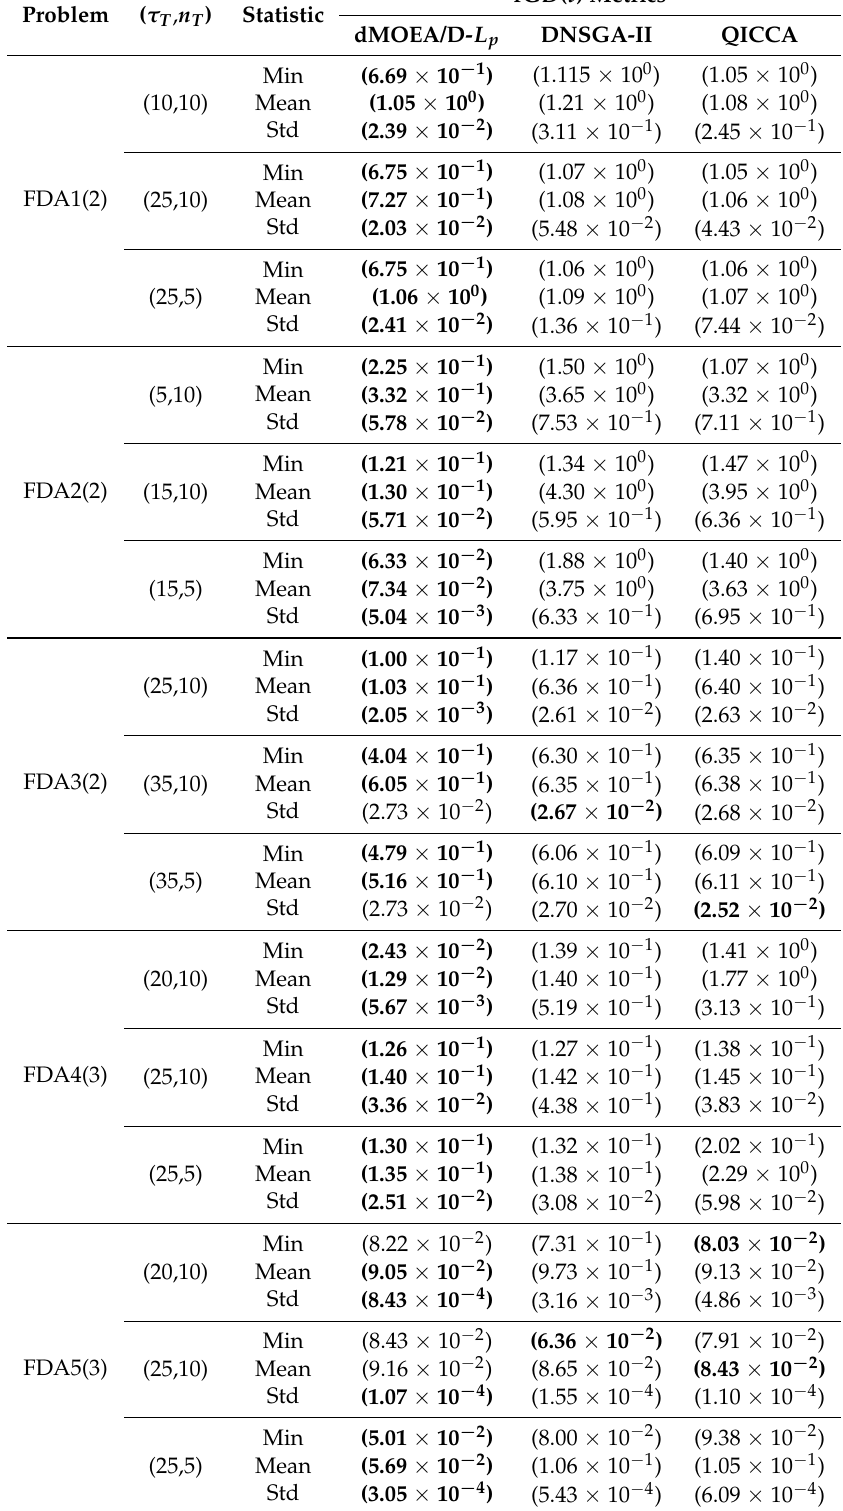
Table 6. The best, mean, and standard deviation of rGD( t ) metric values obtained by dMOEA/D- L p and the other two compared algorithms on test problems based on 30 independent runs. The best performance of each metric value is marked in